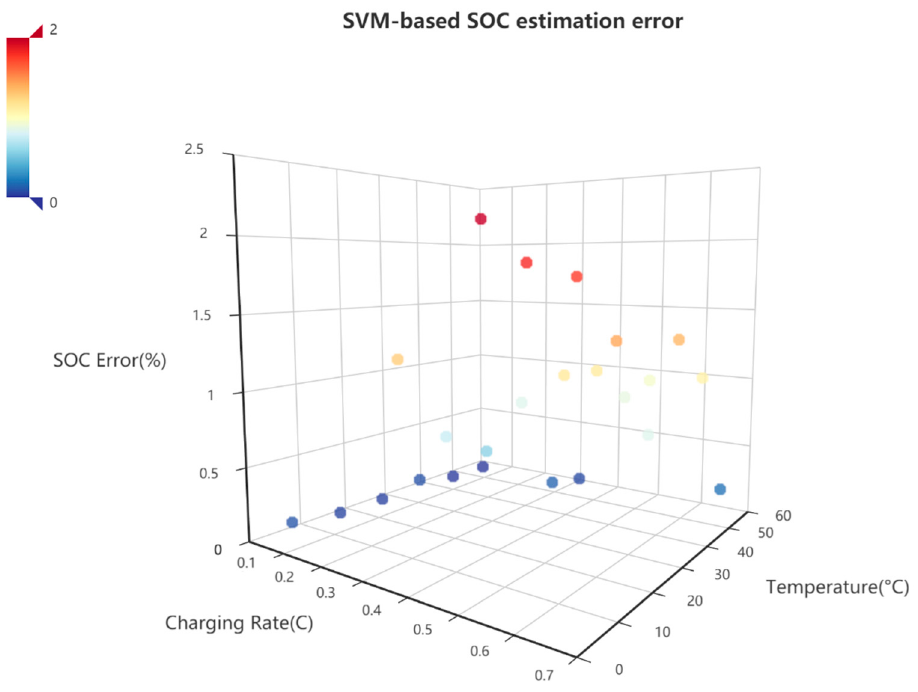
Figure 8. Estimation errors of SVM-based SOC prediction in different working conditions.